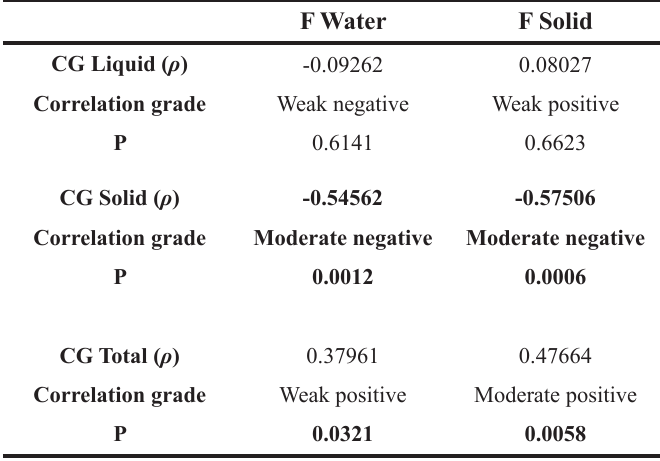
TABLE 2 - Spearman correlation coefficients ( ρ ) between the fasting time and the gastric content.